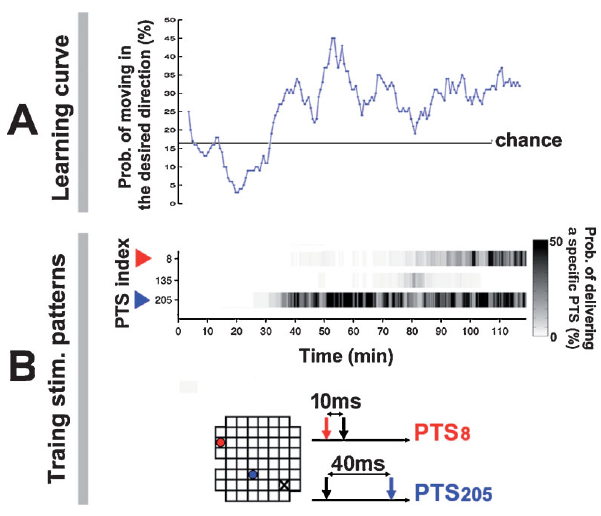
Figure 9. Training series and learning curve for the simulated animat . Animat learning curve and training history in living culture. (Data from the − 45 degree desired angle trial in Figure 7 ). A . A greater portion of animat movementwastowardthedesireddirectionafter30minute.Ananimatmoving randomly would give a 16.67% chance that the movement was within the ± 30 degree range of the desired angle (60 degree/360 degree). B . Training was designed to select the PTS that induced appropriate neural plasticity as determined by subsequent animat behavior. The improved performance at 30minute corresponded to an increase in the occurrence of PTS205, whose paired pulse pattern is shown below; its electrode location is shown in the 8 × 8 grid (blue dot; the probe electrode is a black X). A different PTS pattern increased the RBS occurrence at 80minute